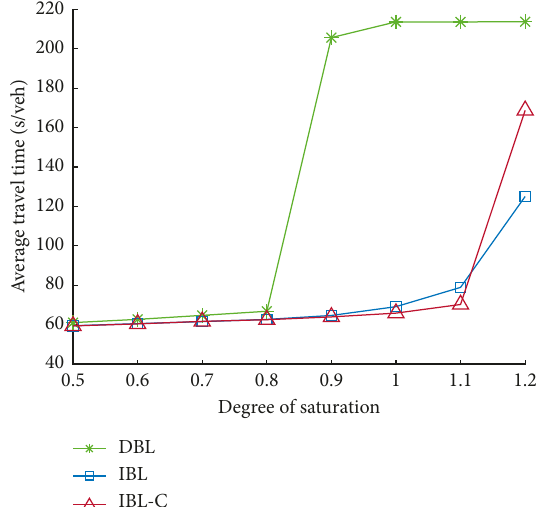
Figure 8: Average traffic time of regular vehicles when the interval of buses is random.